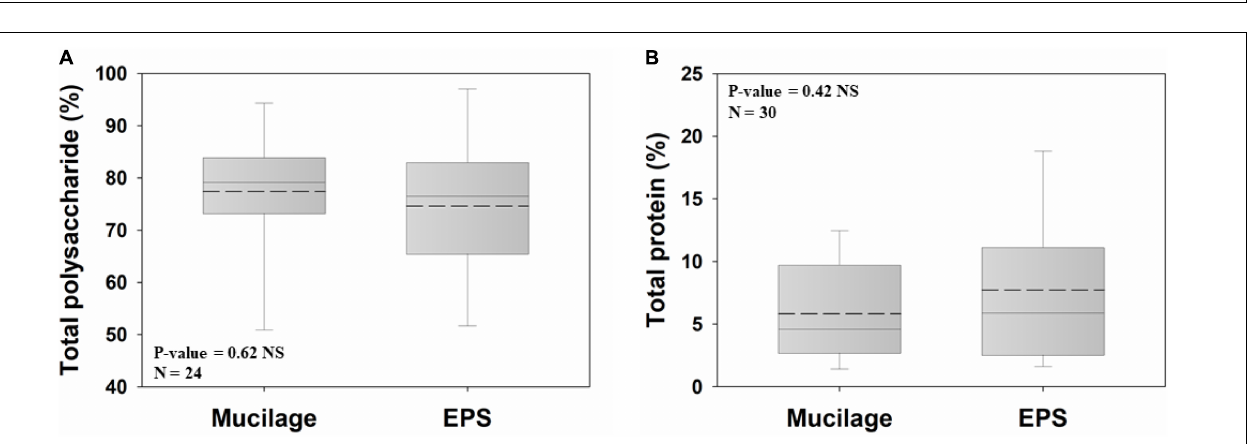
FIGURE 1 | Comparison of mucilage and EPS viscosity (A) and surface tension (B) , using Independent Samples t -test at the significance level of 0.05. The dashed and solid lines on each box indicate the arithmetic mean and median, respectively. The box defines the 25th and 75th percentiles. NS, non-significant; N, number of data points. The viscosity values had been measured at a solute concentration of 0.5 mg ml − 1 , shear rate of 0.5 s − 1 , and temperature of 20–25 ◦ C, and the surface tension values had been measured at a solute concentration of 0.5 mg ml − 1 and temperature of 20–25 ◦ C. Viscosity of water at 25 ◦ C = 0.00089 Pa s; Surface tension of water at 25 ◦ C = 0.072 N m − 1 .